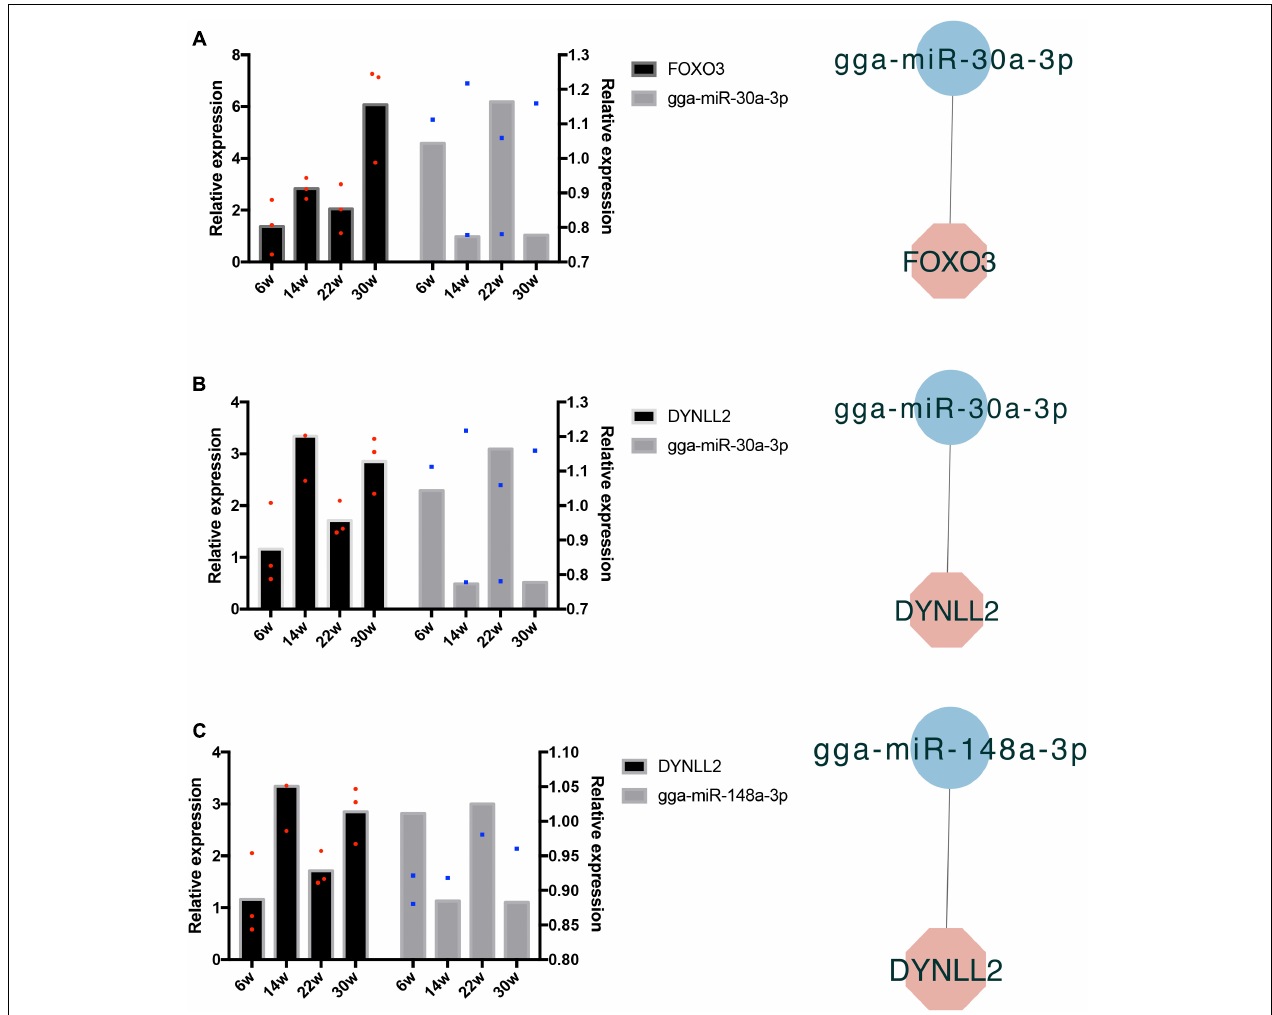
FIGURE 8 | Quantitative real-time PCR validation of differentially expressed miRNAs and their corresponding target mRNAs. The red dots indicate three biological repetition of gene in qRT-PCR result. The blue dots indicate three biological repetition of miRNA in qRT-PCR result. (A) The qRT-PCR validation of miR-30a-3p and its target gene FOXO3 ; (B) The qRT-PCR validation of miR-30a-3p and its target gene DYNLL2; (C) The qRT-PCR validation of miR-148a-3p and its target gene